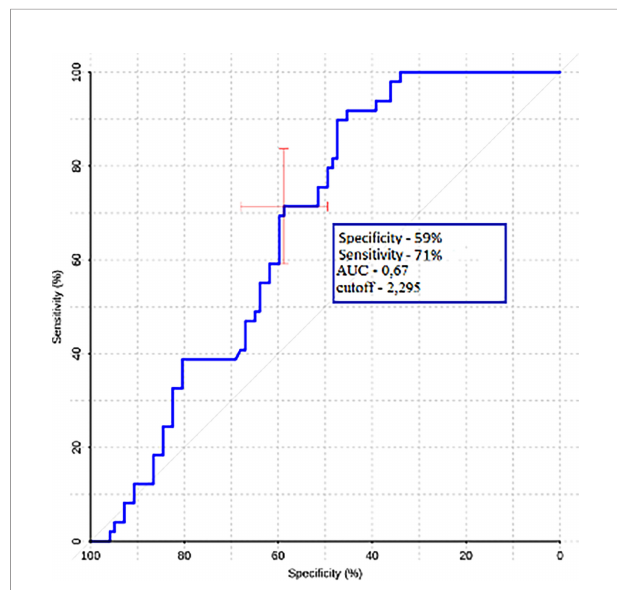
FIGURE 8 | ROC-analysis data obtained by comparing the maximum absolute values of the ROI1 – ROI3 gradient in the groups of metastases and